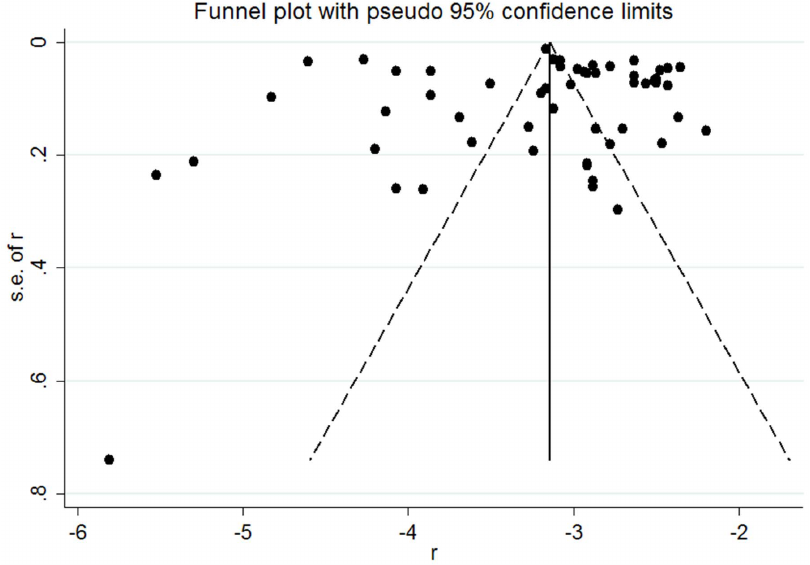
Figure 3. Funnel plot assessing publication bias in the prevalence of AAA from 56 published studies. doi:10.1371/journal.pone.0081260.g003 PLOS ONE |